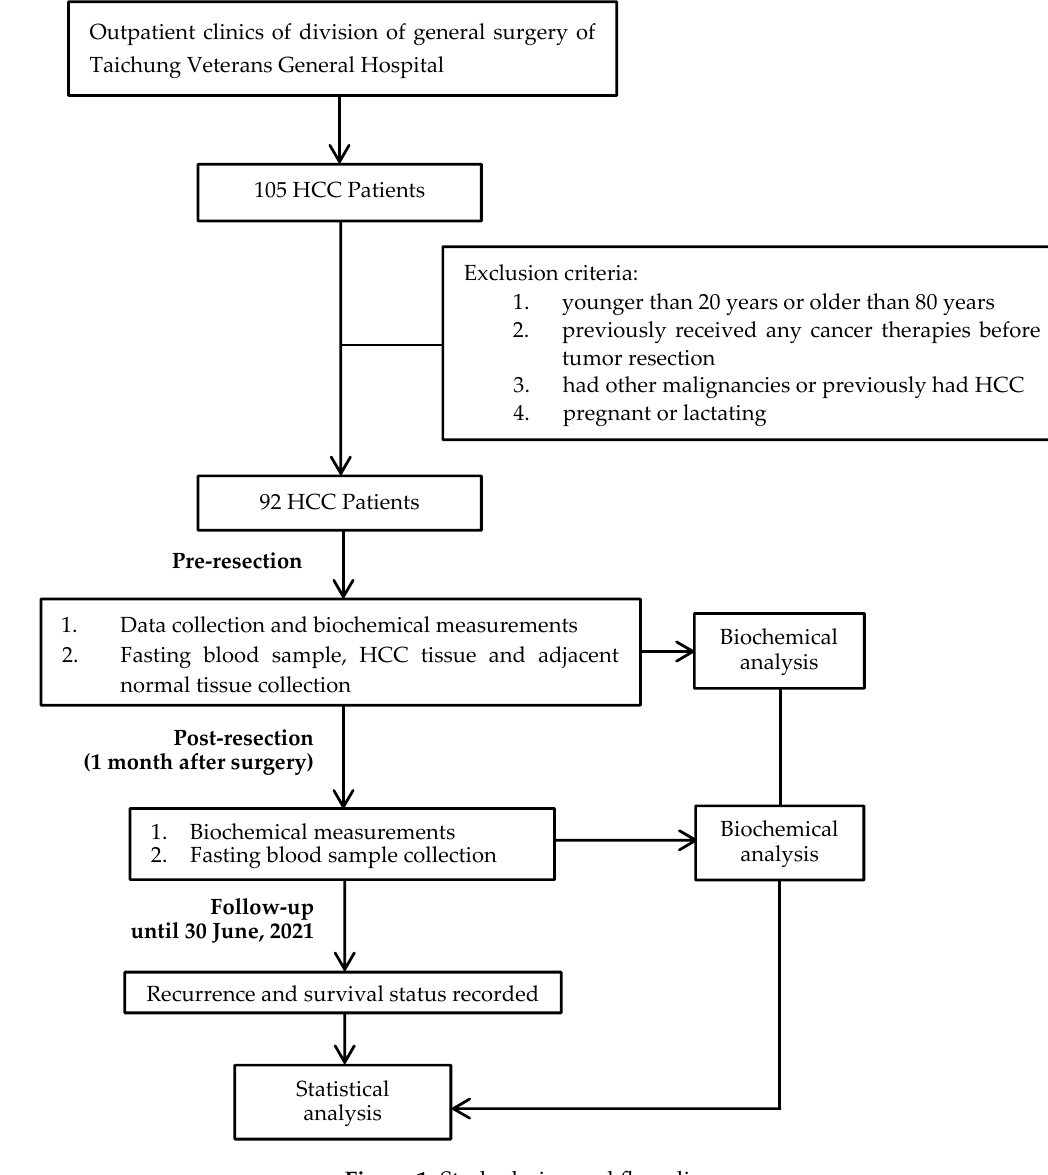
Figure 1. Study design and flow diagram.